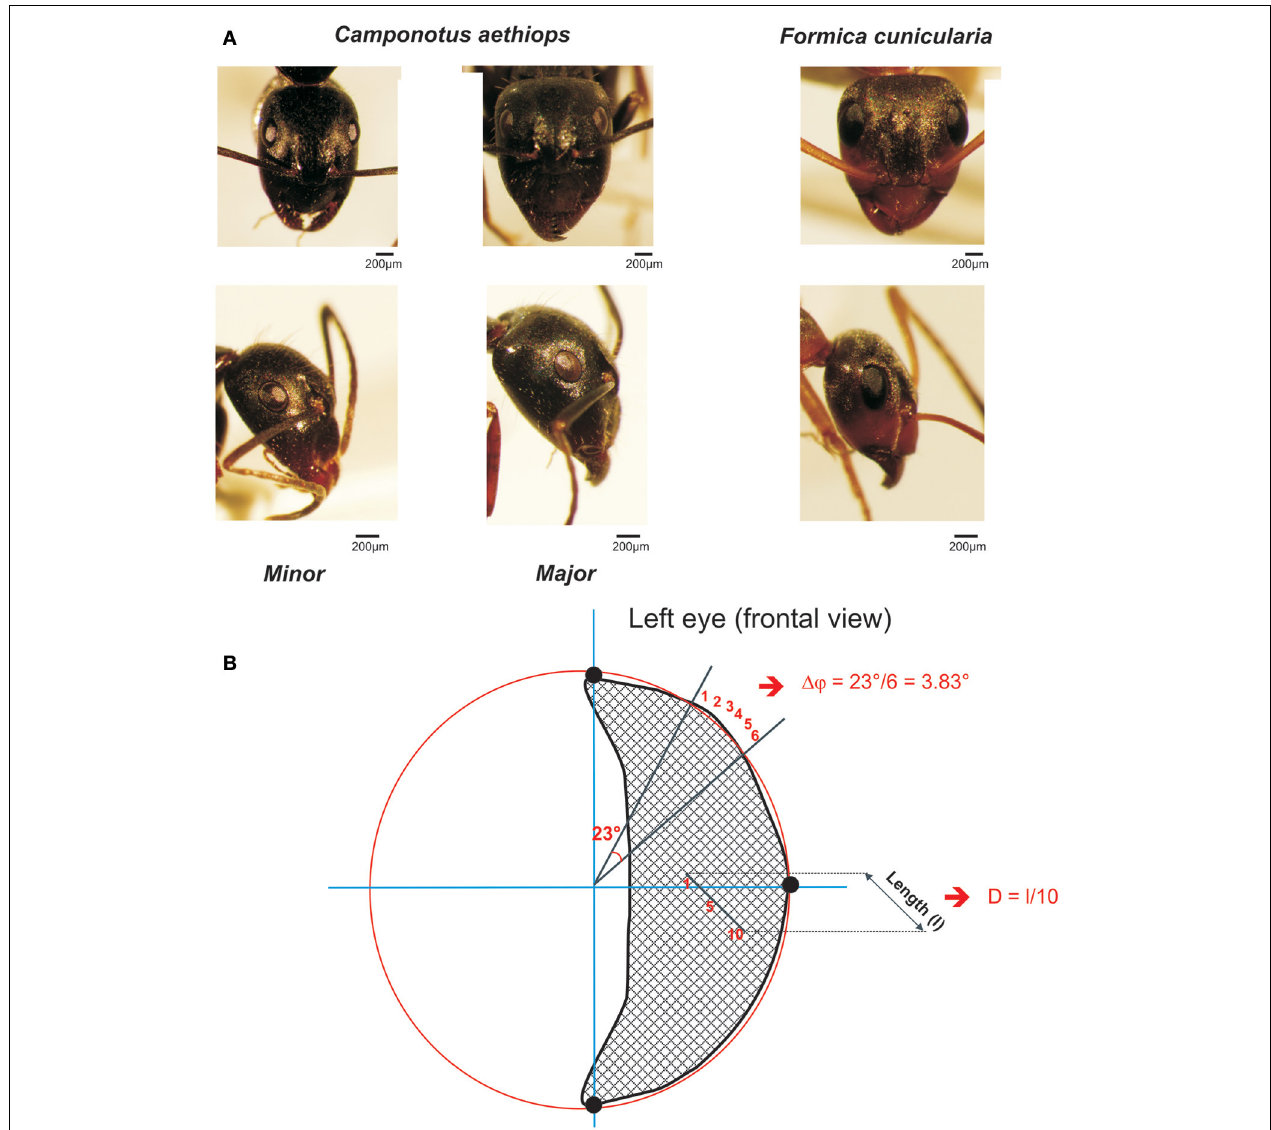
FIGURE 1 | The two sympatric ant species used in this study. (A) Frontal (upper row) and lateral views (lower row) of the heads and compound eye of Camponotus aethiops majors and minors and Formica cunicularia . The scale is indicated in each case. (B) Drawing of a frontal view of a left compound eye to illustrate the calculation procedure for the interommatidial angle ( (cid:2) ϕ ) and the ommatidial diameter . Using the Image J software, three points (black dots) were defined on the outer visible perimeter of the eye and a circle (in red) was drawn to connect them. Two